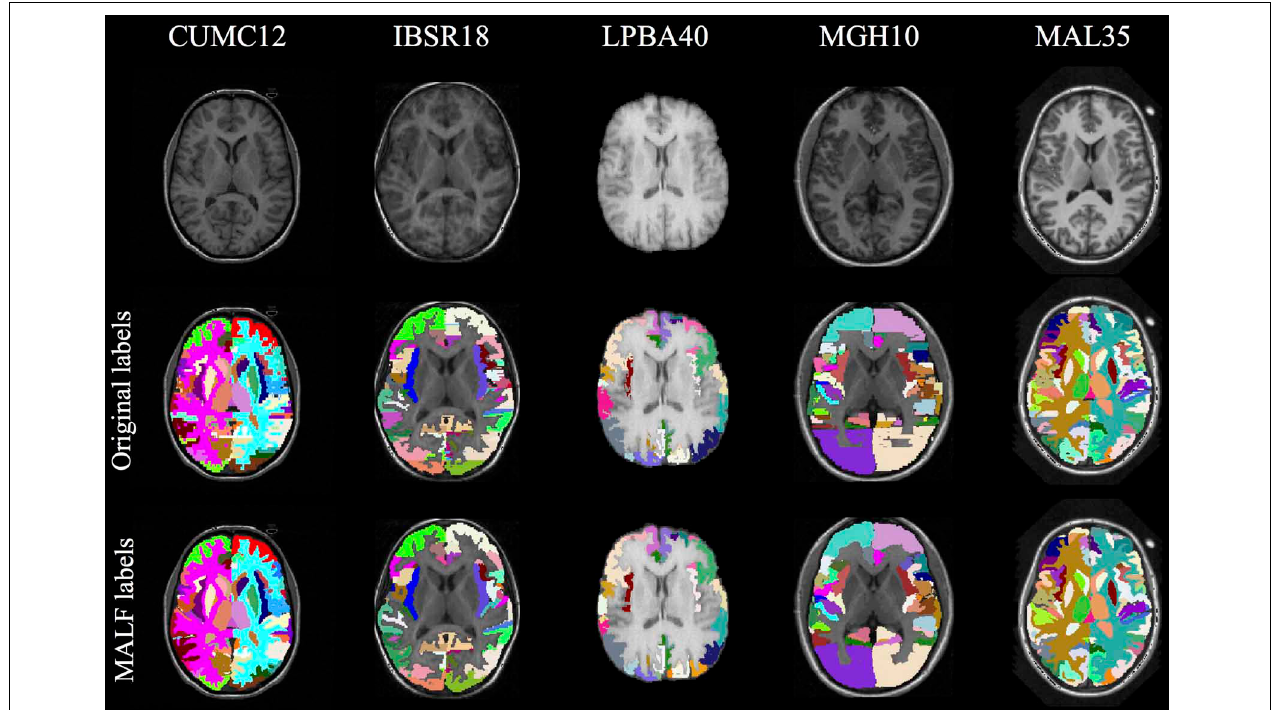
FIGURE 4 | Axial views of sample labelings for a member of each data set. The second row consists of the original labelings with the third row being refined versions of those labelings using the MALF